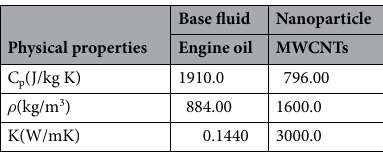
Table 2. Thermophysical attributes of primary fluid (Engine oil) and nanoparticles (MWCNTs) 49 :